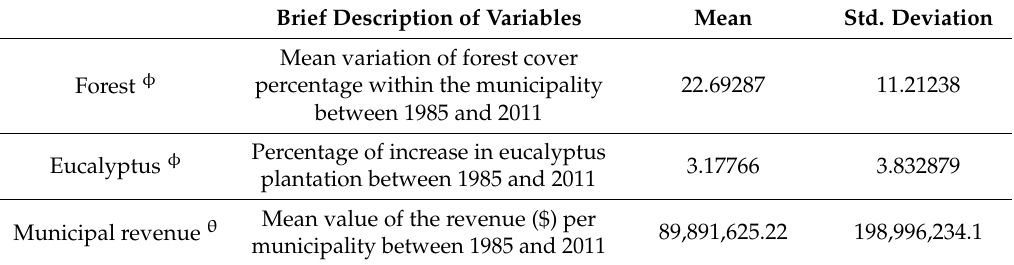
Table 1. Variable dataset to select municipalities within the Para í ba Valley.